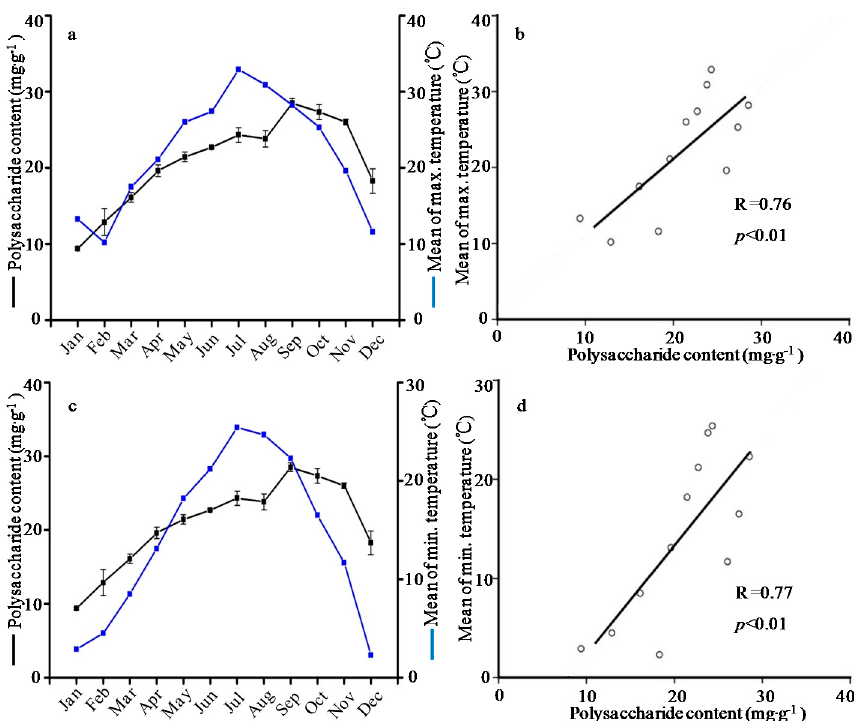
Figure 4. Relationship ( a ) and correlation ( b ) between polysaccharide content and mean of maximum temperature; and relationship ( c ) and correlation ( d ) between polysaccharide content and mean of minimum temperature.